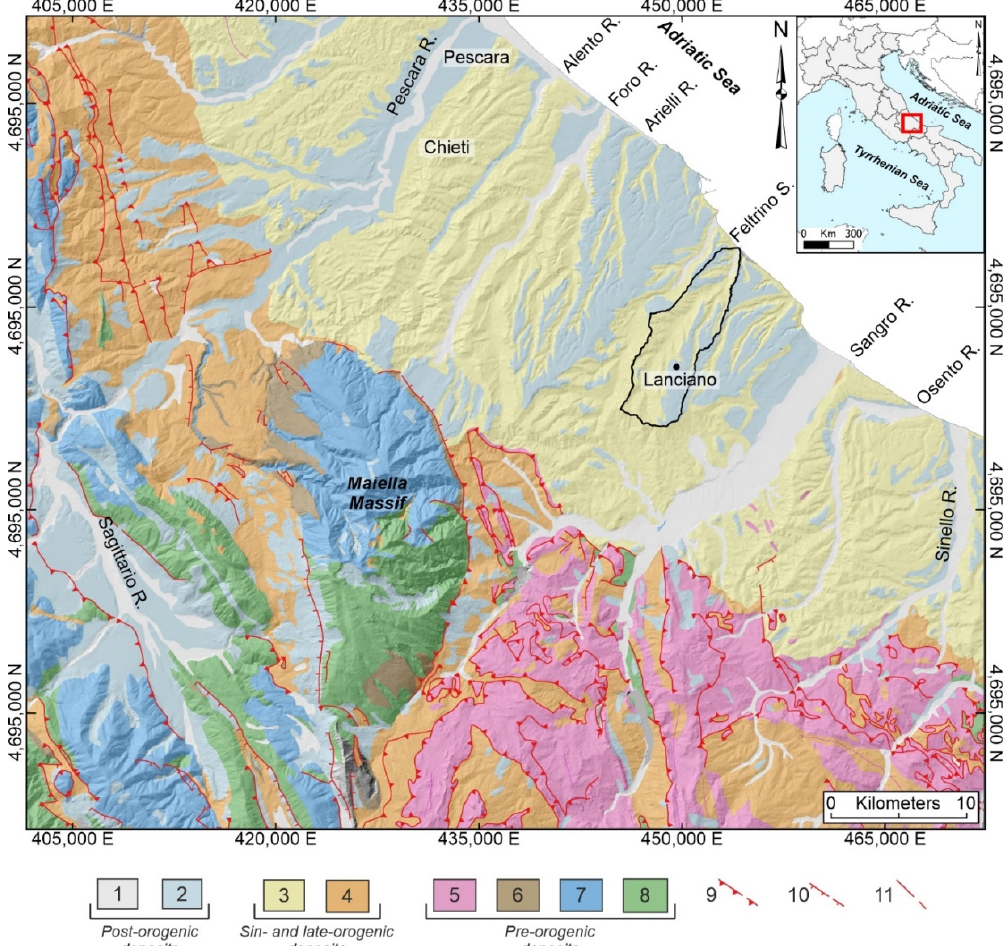
Figure 1. Geological sketch map of the northeast (NE) Abruzzo. Black line: The Feltrino Stream basin. Legend: post-orogenic deposits—(1) fluvial deposits (Holocene), (2) fluvial and alluvial fan terraced deposits (Middle–Late Pleistocene); sin-and late-orogenic deposits, (3) clay, sand, and sandstone of hemipelagic sequences with conglomerate levels (Early Pleistocene), (4) pelitic–arenaceous turbiditic foredeep sequences (Late Miocene–Early Pliocene); pre-orogenic deposits, (5) marl–clay–limestone of the Molise pelagic sequences (Oligocene–Miocene), (6) limestone of carbonate ramp facies (Early Miocene–Early Pliocene), (7) limestone and marl of slope and pelagic basin sequences (Cretaceous–Miocene), (8) limestone of carbonate platform sequences (Jurassic–Miocene); (9) major thrust (dashed if buried); (10) major normal fault (dashed if buried); (11) major fault with strike–slip or reverse component (dashed if buried).